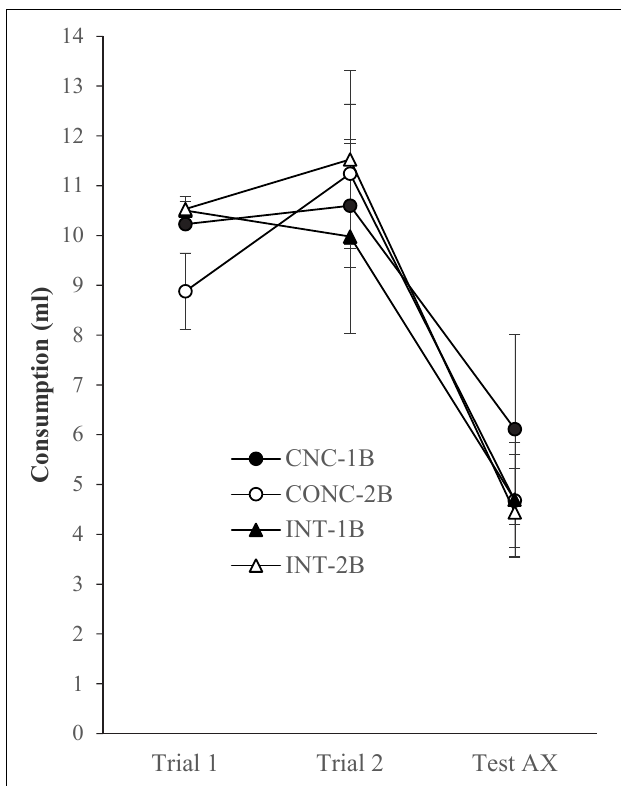
FIGURE 6 | Consumption (ml, mean ± SEM) of the AX solution during the two conditioning trials and the test for the four groups of Experiment 4.